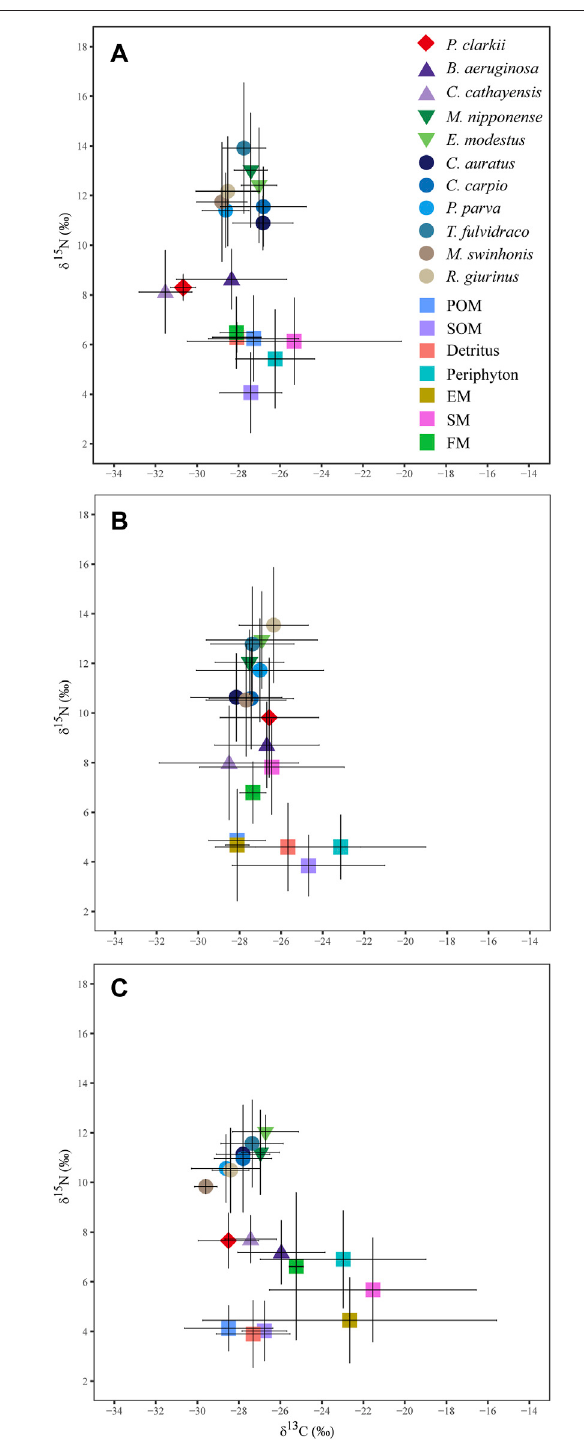
FIGURE 2 | Mean (± 1 SD) values of δ 13 C and δ 15 N of the red swamp cray fi sh (diamonds), snail species (inverted triangles), prawn species (upright triangles), fi sh species (circles) and their potential food sources (squares) from Poyang Lake in May (A) , July (B) and October (C) 2019. POM =